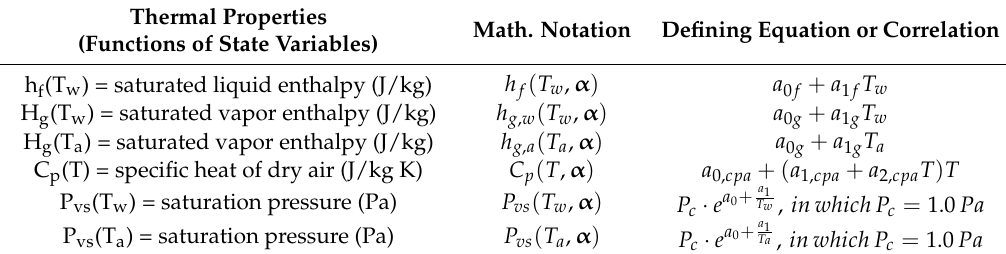
Table B3. Thermal Properties (Dependent Scalar Model Parameters).